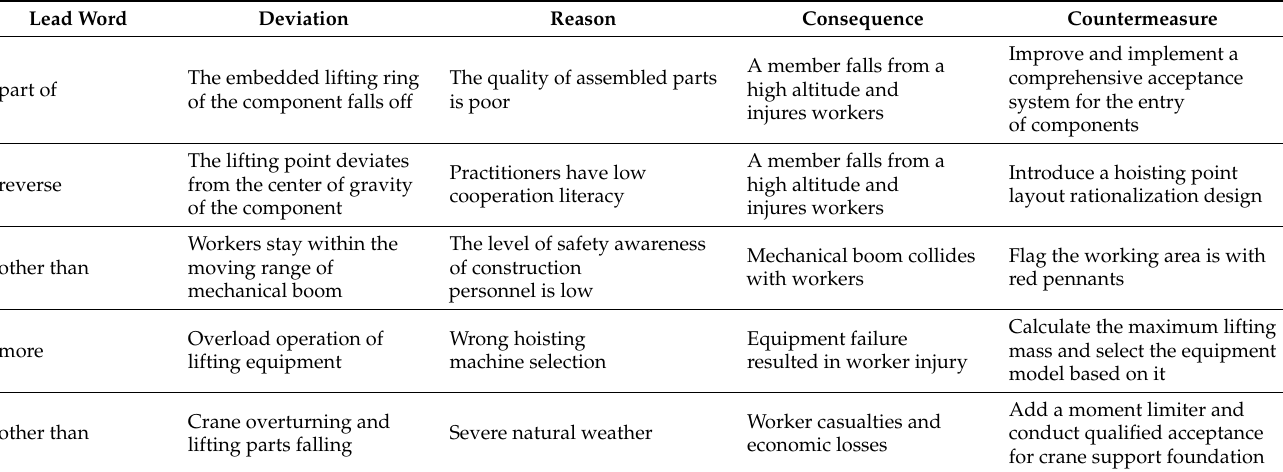
Table 9. HAZOP analysis of the components lifting phase.